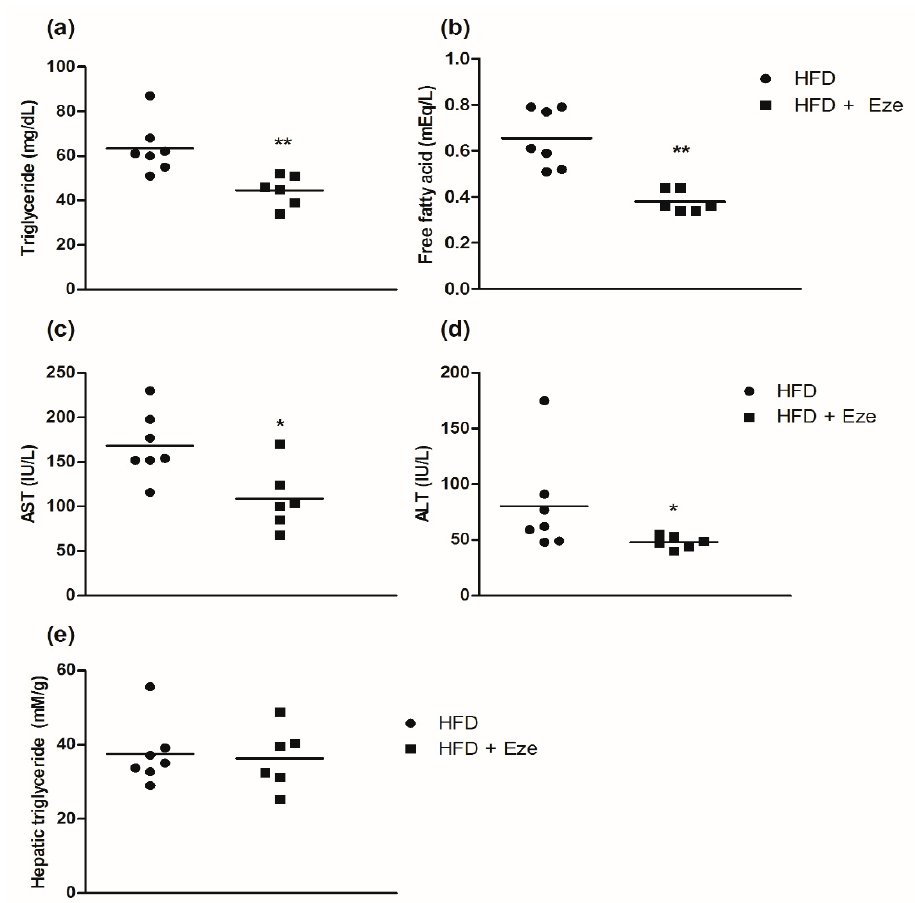
Figure 2. Effects of ezetimibe on triglyceride levels, free fatty acid levels, aspartate aminotransferase (AST) levels, alanine aminotransferase (ALT) levels, and hepatic triglyceride levels. ( a ) Triglyceride levels, ( b ) free fatty acid levels, ( c ) AST (IU/L) levels, ( d ) ALT (IU/L) levels, and ( e ) hepatic triglyceride (mM/g) levels. The hepatic triglyceride levels were measured using a triglyceride quantification kit (Abcam, Cat. No. ab65336). Compared using the Wilcoxon-Mann-Whitney U test; * p < 0.05, ** p < 0.01. AST; aspartate aminotransferase, IU/L; international units per liter, ALT; alanine aminotransferase. Several of the glucose metabolism indices partially improved in the rats in the ezetimibe group.